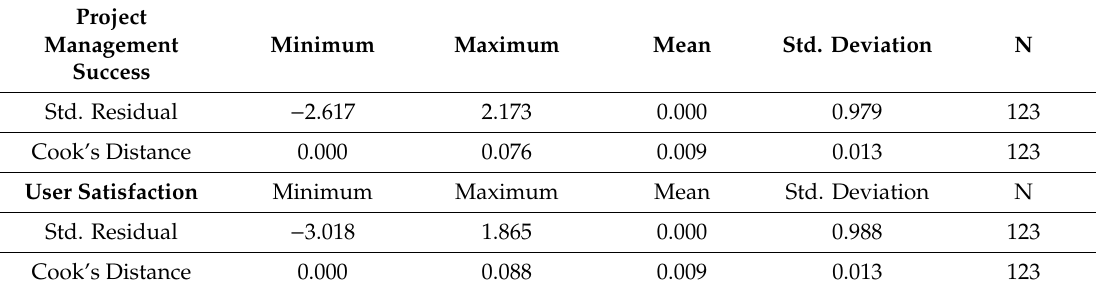
Table 6. Residuals